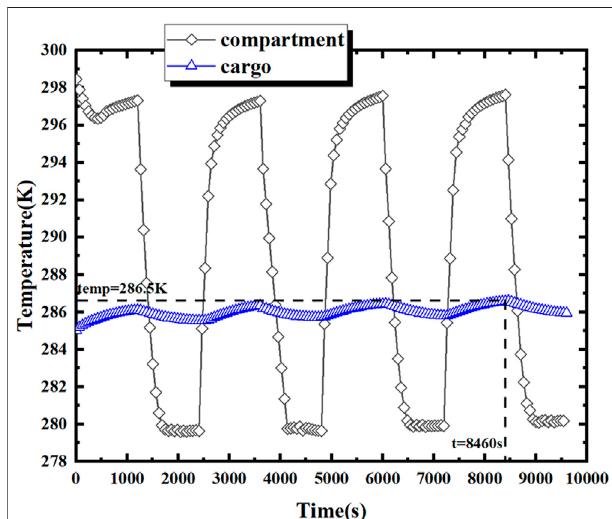
FIGURE 11 | Cooling condition